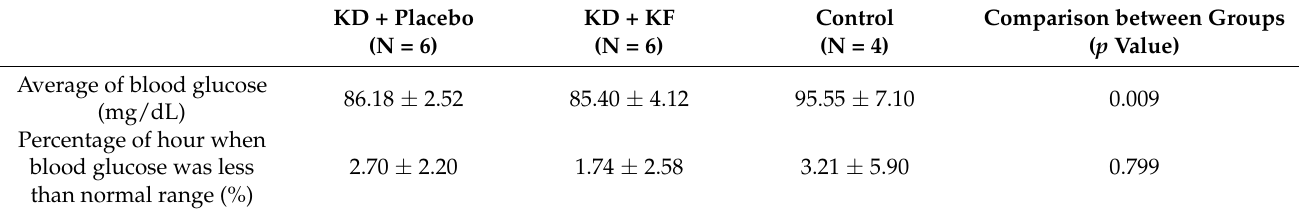
Table 6. Analysis of continuous blood glucose monitoring.